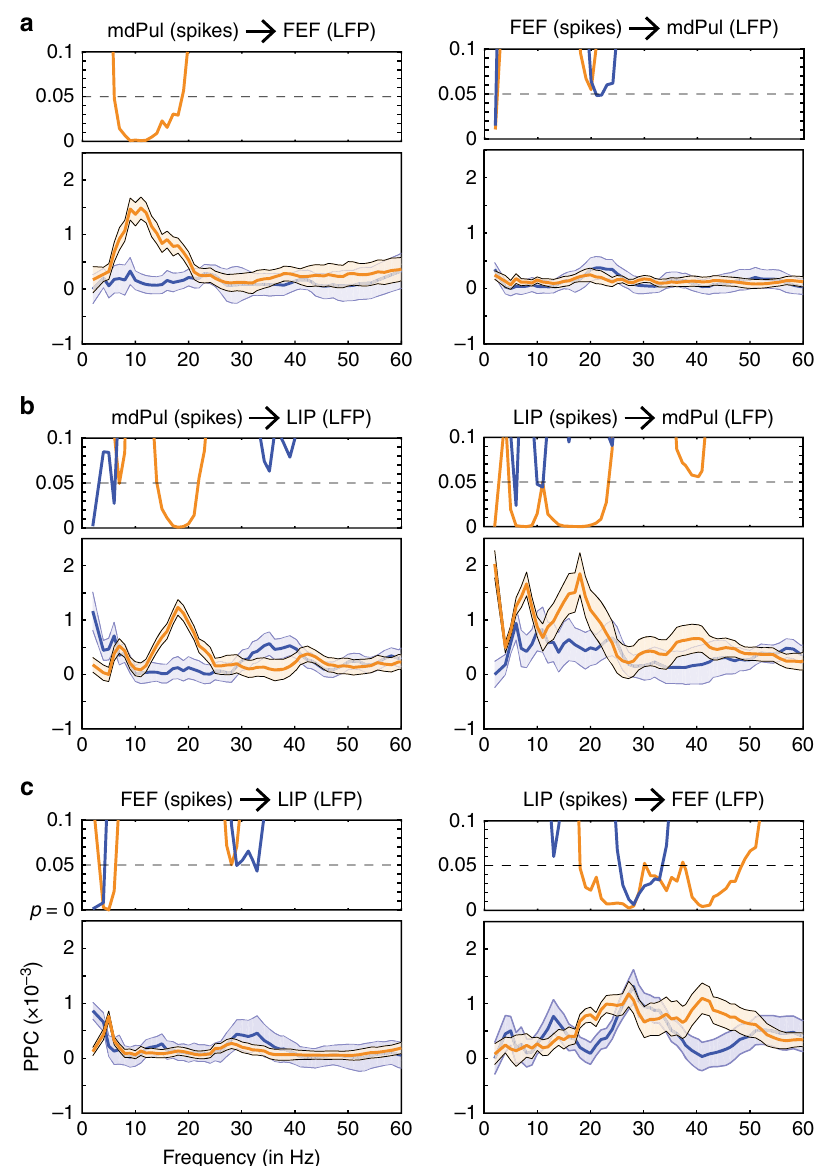
Fig. 5 Spike – LFP phase coupling demonstrates increased functional connectivity between mdPul and cortex during spatial attention. The top panel of each plot shows p -values, indicating whether spike – LFP phase coupling is statistically signi fi cant for each condition, cued (orange), or non-cued (blue). The bottom panel compares spike – LFP phase coupling between the two conditions (cued vs. non-cued). Panel a examines spike – LFP phase coupling between mdPul and FEF, panel b examines spike – LFP phase coupling between mdPul and LIP, and c examines spike – LFP phase coupling between FEF and LIP. These plots are based on data from all task-responsive neurons (see Supplementary Table 1). Shaded regions around the lines represent